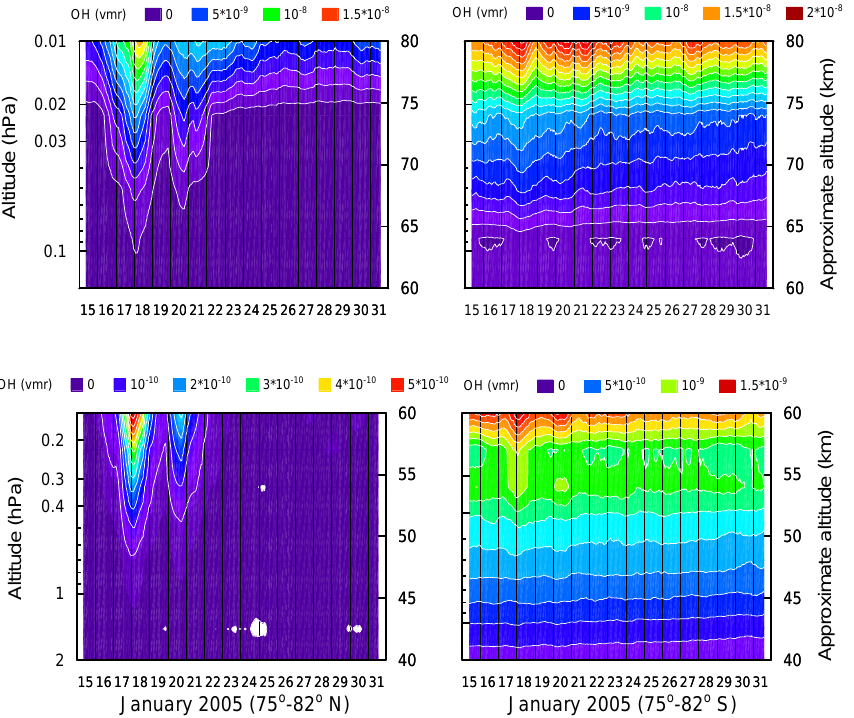
Fig. 3. Temporal evolution of averaged values ( ∼ 75 ◦ –82 ◦ N and S) of January 2005 OH volume mixing ratio (vmr), approximately in mesosphere (top) and in upper stratosphere (bottom). The left column reports the Northern Hemisphere and the right the Southern one (see the caption of Fig. 2 for the correspondent